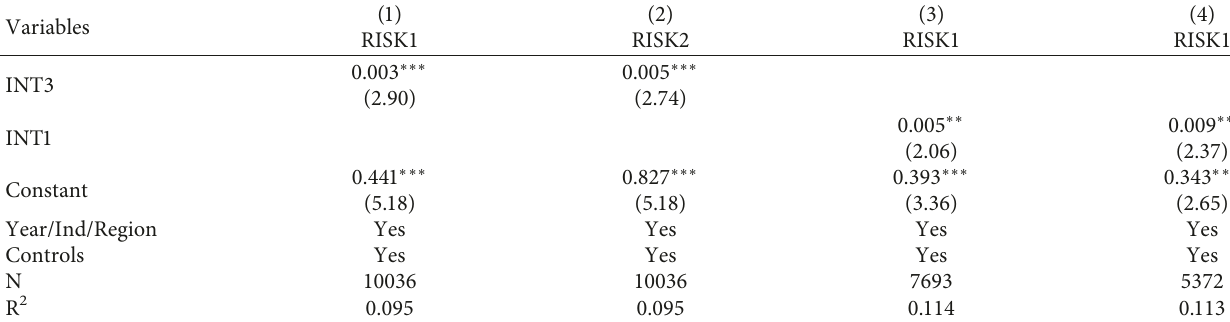
Table 6: Robustness